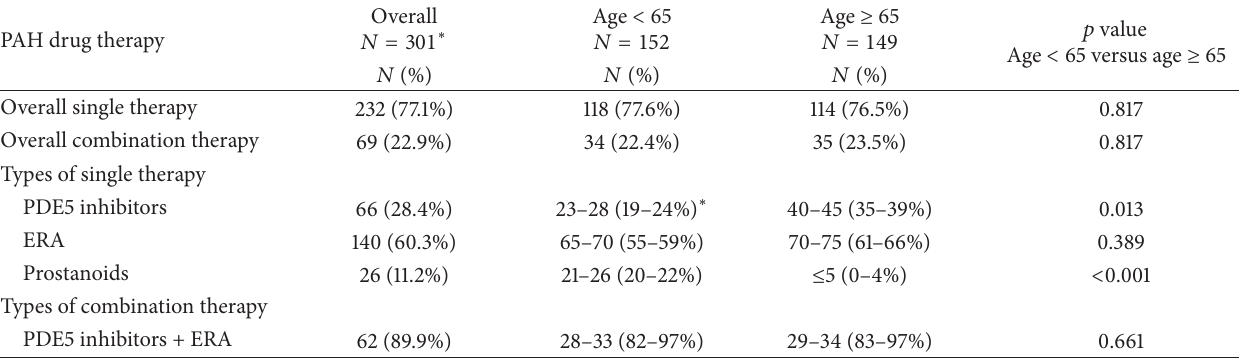
Table 2: Overall and age-stratified PAH drug therapy utilization patterns in Ontario between April 1, 2011, and March 31, 2012. PAH drug therapy